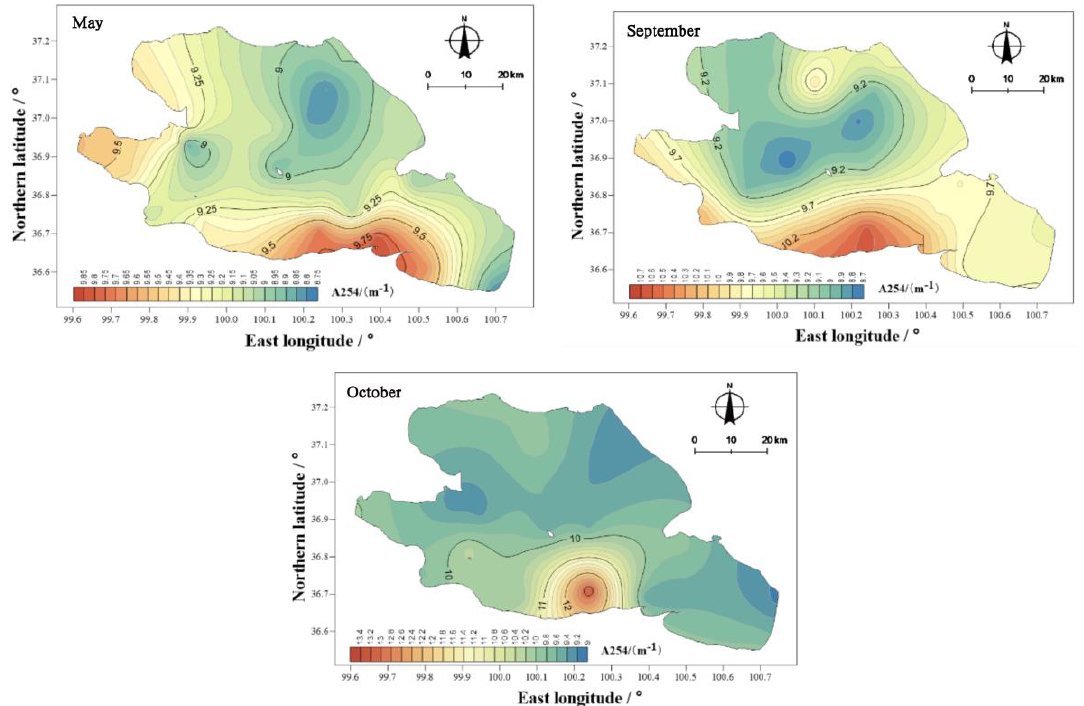
Figure 11. Spatial distribution characteristics of the CDOM concentration (a 254 , m − 1 ) in the water body of Qinghai Lake in different seasons.